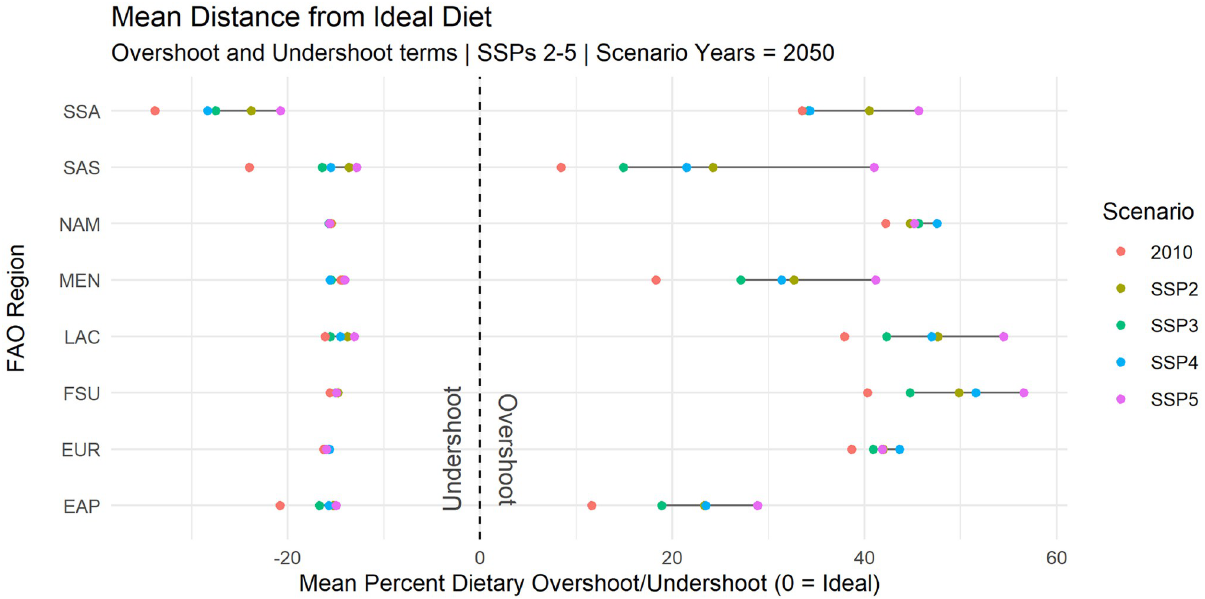
Fig 4. 2050 projected percent of total diet that is satisfied through imported goods. Region-level values are population-weighted country-level averages of the portion of average diet imported. Regions as follows: SSA = Sub-Saharan Africa, SAS = South Asian States, NAM = North America, MEN = Middle East/North Africa, LAC = Latin America and Caribbean, FSU = Former Soviet Union, EUR = Europe, EAP = East Asia